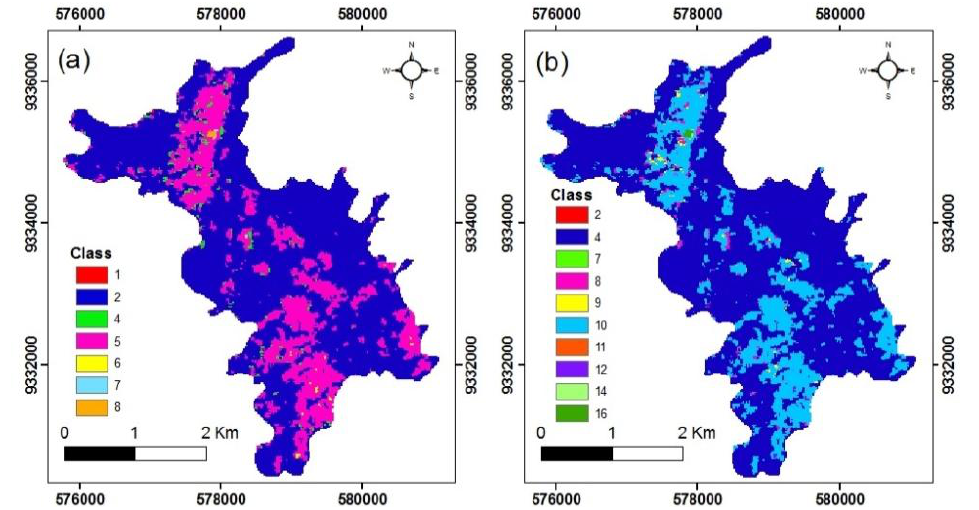
Figure 4. Classification of the R99B image by the decomposition method based. ( a ) the H- reference plane; ( b ) the H- -A reference